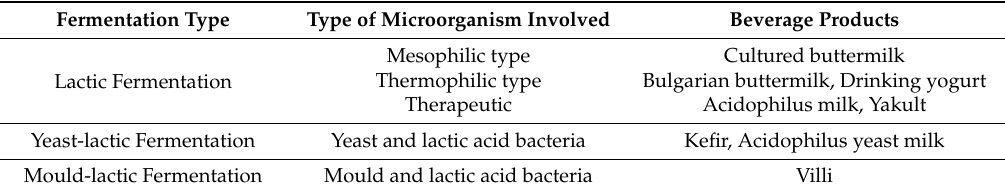
Table 6. Types of fermentation used to produce different fermented dairy beverages.